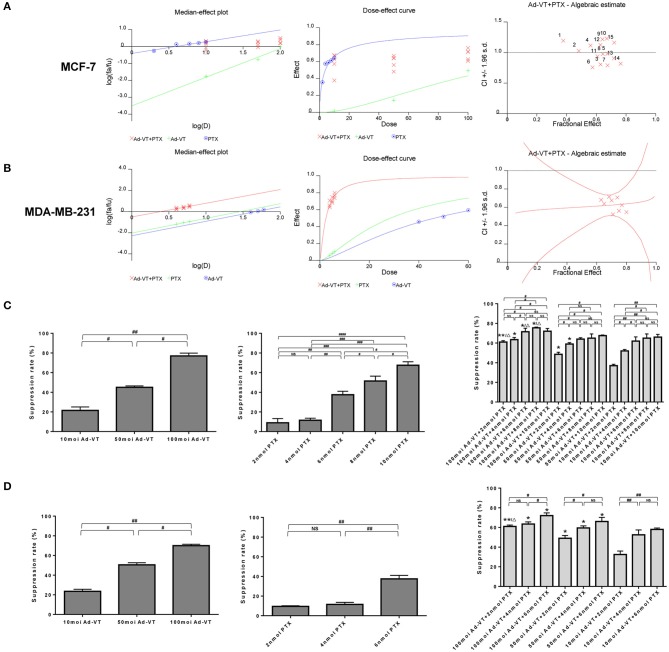
Synergistic analysis of the combination of Ad-VT and paclitaxel. (A) Calcusyn software analysis of the synergy between the Ad-VT and paclitaxel and evaluation of the drug concentration in MCF-7 cells. The CI of 50 MOI Ad-VT + 2 nmol paclitaxel group (CI = 0.997), 50 MOI Ad-VT + 4 nmol paclitaxel group (CI = 0.936), 50 MOI Ad-VT +6 nmol paclitaxel group (CI = 0.982), 100 MOI Ad-VT + 6 nmol paclitaxel group (CI = 0.942), 10 MOI Ad-VT + 2 nmol paclitaxel group (CI = 0.989), 10 MOI Ad-VT + 6 nmol paclitaxel group (CI = 0.975) and 10 MOI Ad-VT + 10 nmol paclitaxel group (CI = 0.977) were <1, indicating a synergistic inhibitory effect. (B) Synergistic effect test on MDA-MB-231 cells to determine the concentration of virus and drug. Finally, 50 MOI Ad-VT + 4 nmol (CI = 0.942) paclitaxel was selected for subsequent in vitro inhibition experiments. (C) Inhibitory effects of different concentrations of Ad-VT and paclitaxel on MCF-7 cells assessed by the WST-1 assay. (D) Inhibitory effects of different concentrations of Ad-VT and paclitaxel on MDA-MB-231 cells assessed by WST-1 assay. The WST-1 assays were performed in triplicate. #p < 0.05, ##p < 0.01, ###p < 0.001, ####p < 0.0001. (When compared with the 10 MOI Ad-VT group at the same paclitaxel concentration, *p < 0.05, **p < 0.01; compared with the 50 MOI Ad-VT group at the same paclitaxel concentration, Δp < 0.05).